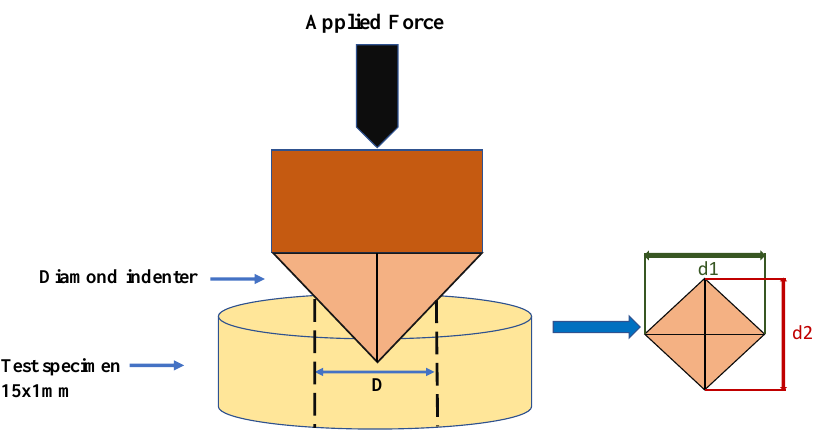
Figure 2. Schematic representation of surface hardness test.